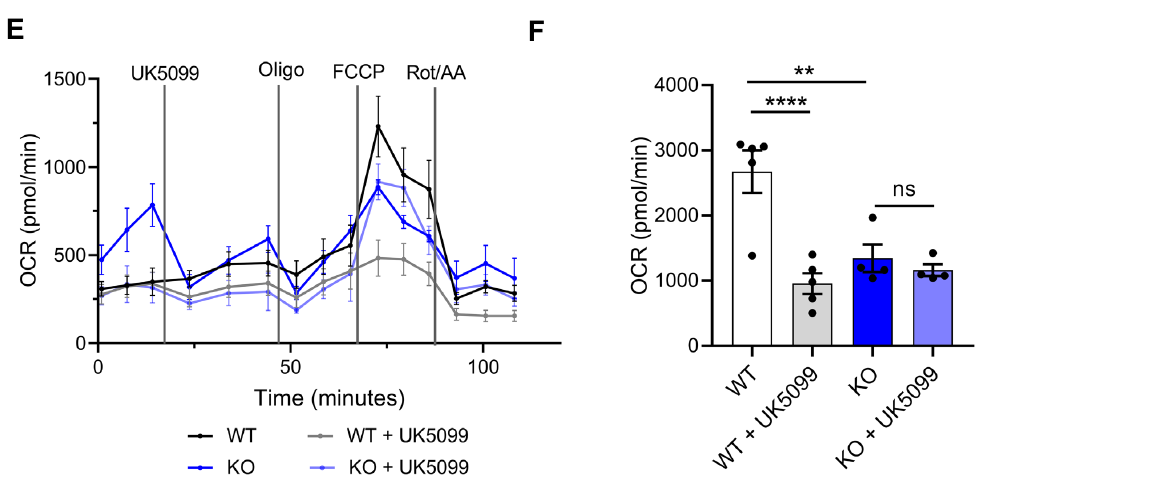
Figure 3. Decreased cardiomyocyte oxidative metabolism and reduced cardiac insulin response in CTRP9 knock-out mice during high-fat diet (HFD). ( A ) Representative images of whole mouse and cardiac PET scans of HFD-fed mice of the indicated genotypes. 18 F-fluoro-deoxyglucose was used as a tracer. ( B ) Dynamic glucose uptake measured through PET scans, and its quantification in ( C ). WT: wild-type mice (+/+); KO: homozygous CTRP9 knock-out mice ( − / − ). ( D ) Immunoblot of cardiac protein lysate of mice of the indicated genotype and treated as shown. GAPDH was used as a loading control. INS: insulin. ( E , F ) Seahorse analysis of cardiomyocytes isolated from the indicated mice and treated as shown during the analysis. ( E ) Kinetic graph of the glucose/pyruvate stress test assay, and ( F ) bar chart of maximum respiration with or without inhibition of the mitochondrial pyruvate carrier by UK5099. Oligo: Oligomycin, Rot/AA: Rotenone/antimycin A. Data are shown as mean ± standard error of the mean (SEM). * p < 0.05, ** p < 0.01, **** p <